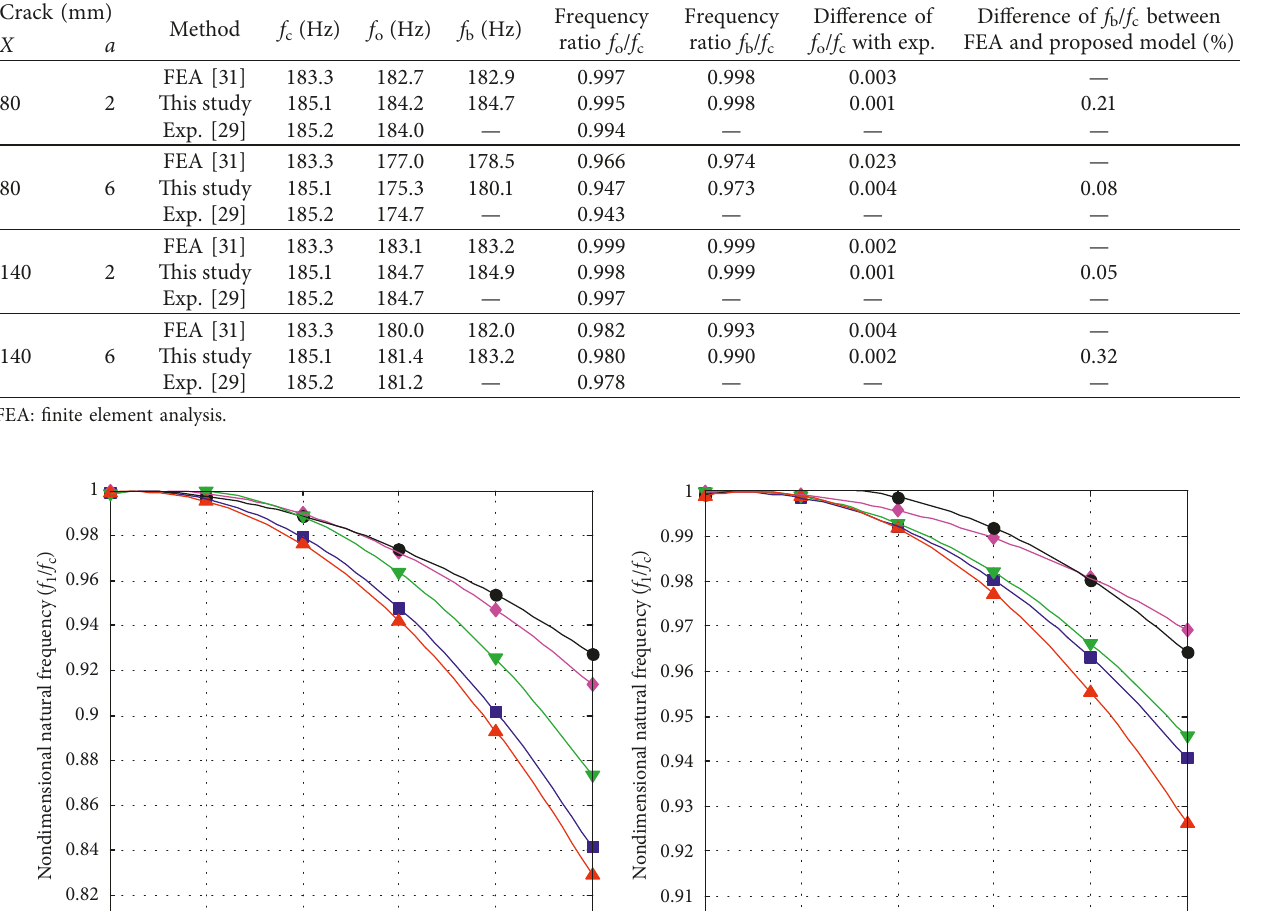
Table 3: Comparison of the fundamental natural frequency from the proposed model with those from the FEA and experimental in- vestigation for a cantilever beam with open crack and breathing crack. Crack (mm)